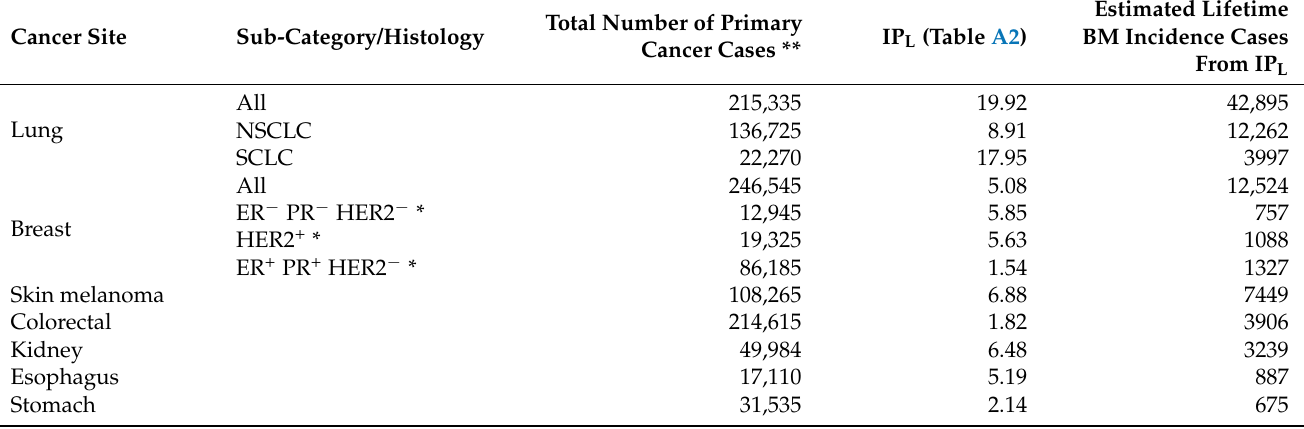
Table 4. Estimated lifetime incidence proportion (IP L ) and frequency of brain metastases by selected primary site (2010–2017) for all Canadian provinces and